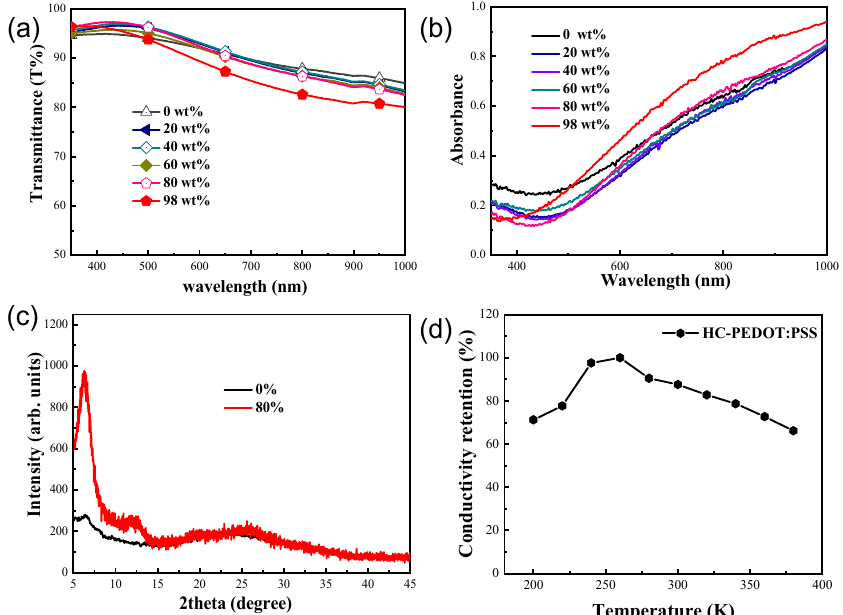
Figure 2. ( a ) Transmittance and ( b ) absorbance of PEDOT:PSS films treated by H 2 SO 4 with different concentrations (0 wt%, 20 wt%, 40 wt%, 60 wt%, 80 wt%, 98 wt%), ( c ) XRD characteristics of 80 wt% H 2 SO 4 treated PEDOT:PSS film and pristine PEDOT:PSS (PH1000) film, ( d ) the conductivity-temperature dependent test on HC-PEDOT:PSS film.